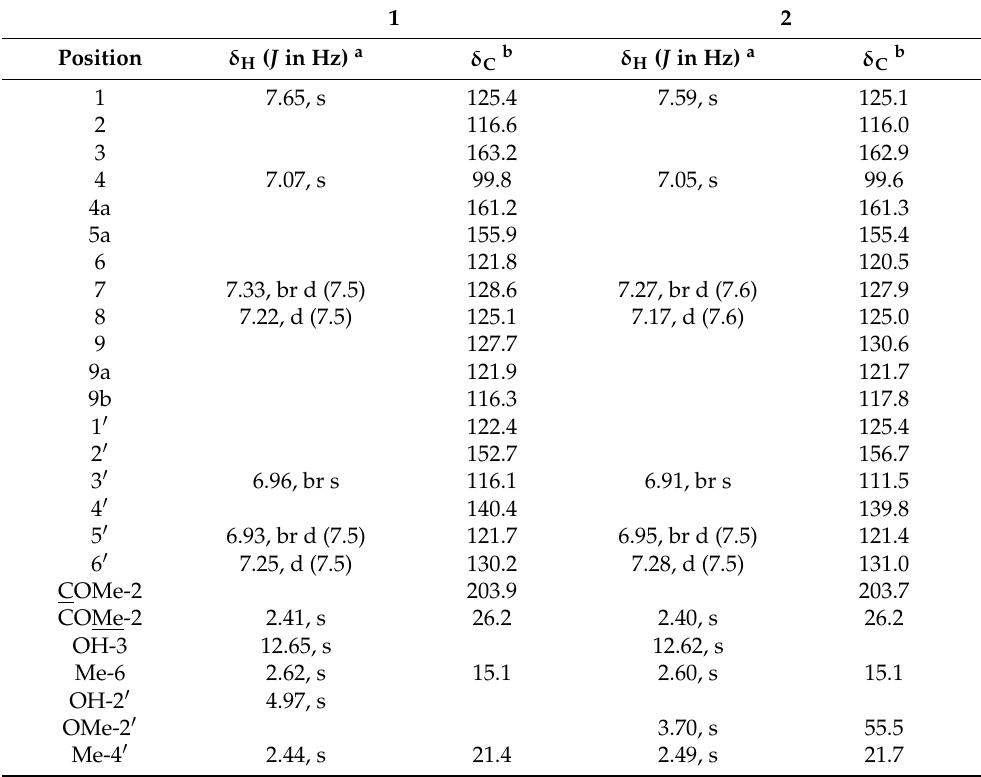
Table 1. 1 H and 13 C NMR data of 1 and 2